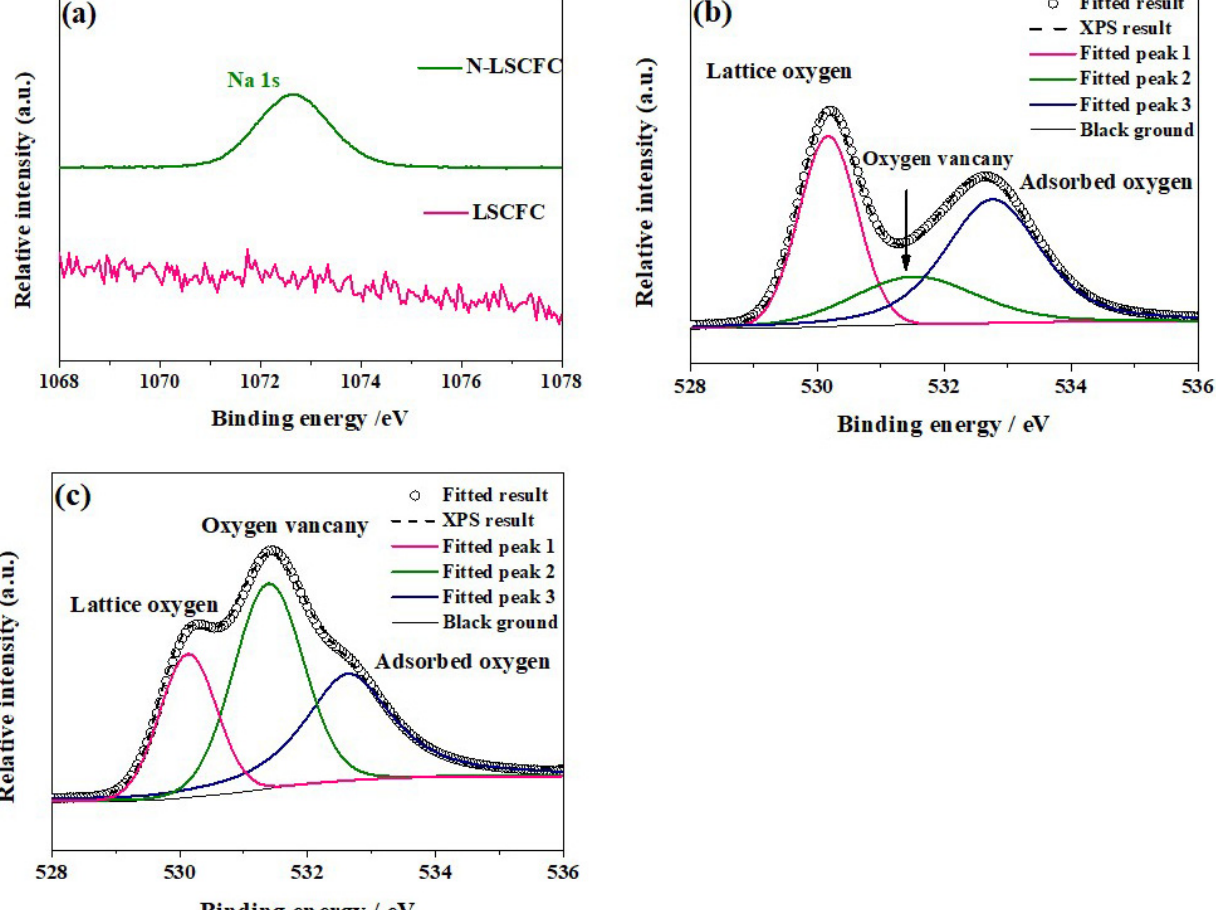
Figure 2. ( a ) XPS spectra of Na1s for LSCFC and N-LSCFC, and XPS spectra of O1s for ( b ) LSCFC and ( c ) N-LSCFC.